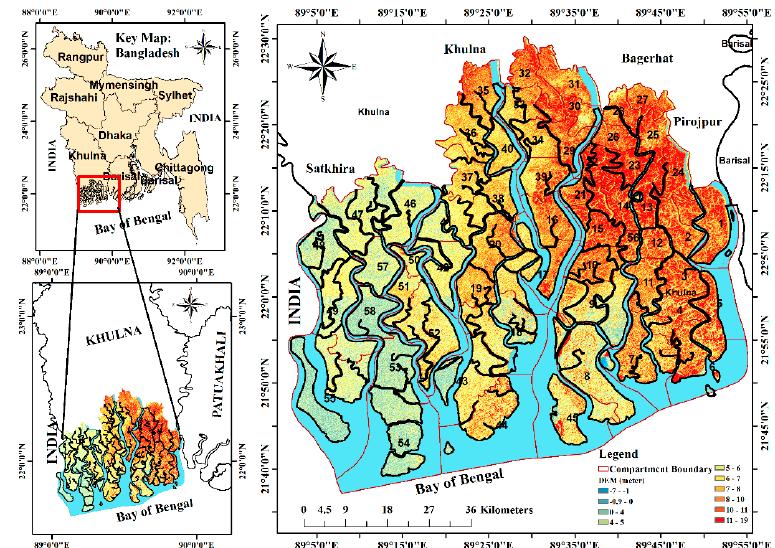
Figure 1. Location of the study area, Sundarban Reserve Forest (SRF), Bangladesh. Top left panel represents key map: red bounding box shows an overview of SRF; bottom left panel indicates zoomed-in view with digital elevation model (DEM); right panel indicates DEM of the study (elevation in meters) with overlay of forest compartment boundaries represented with the red polygon and compartment numbers in black and bold.